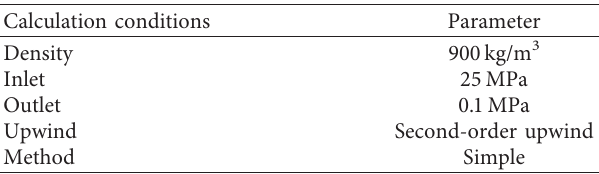
Figure 7: End clearance flow field Table 3: Boundary conditions of numerical simulation.